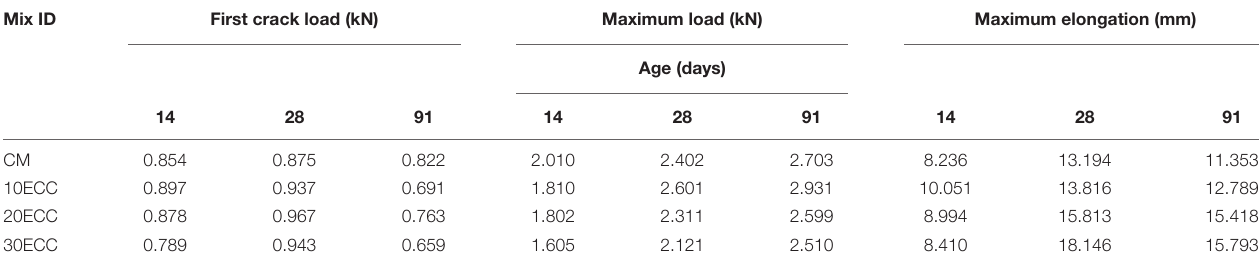
TABLE 4 | Comparison of the first crack load, maximum load, and maximum elongation among different ECC mixes with aging. Mix ID